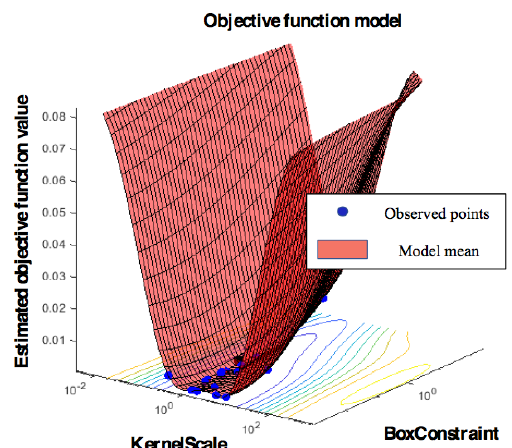
Figure 9. Objective function values for hyperparameter tuning using Bayesian optimizer. The optimal SVM parameters are C = 7 (box constraint) and σ = 2 (kernel scale).